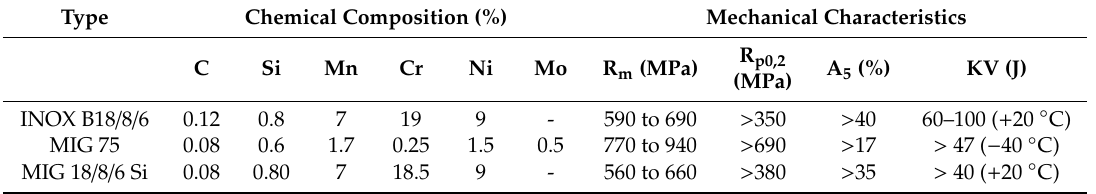
Figure 2. Cross-sections of metallographic samples with directions and microhardness measuring spots: ( a ) the MMA / MAG weld; ( b ) the MIG / MAG weld. Table 3. Chemical composition and mechanical characteristics of thefiller materials used.